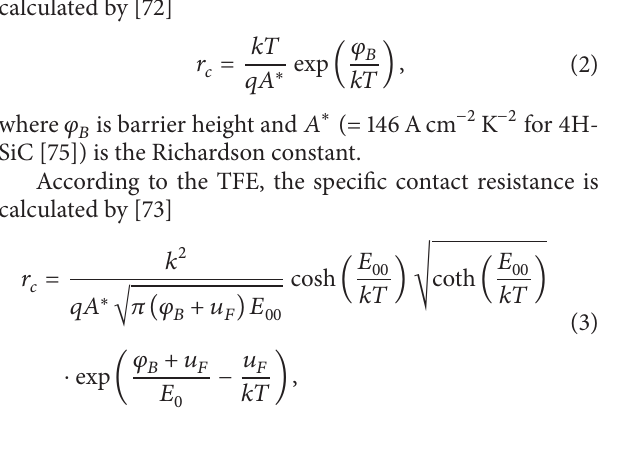
(TE, 𝐸 00 /𝑘𝑇 ≪ 1 ) [73]. In our case ( n -type 4H-SiC) and at our maximum doping level of 1 × 10 19 cm −3 , 𝑚 ∗ = 0.36𝑚 0 , and 𝜀 = 9.66𝜀 0 , 𝐸 00 was found to be about 31.5 meV.